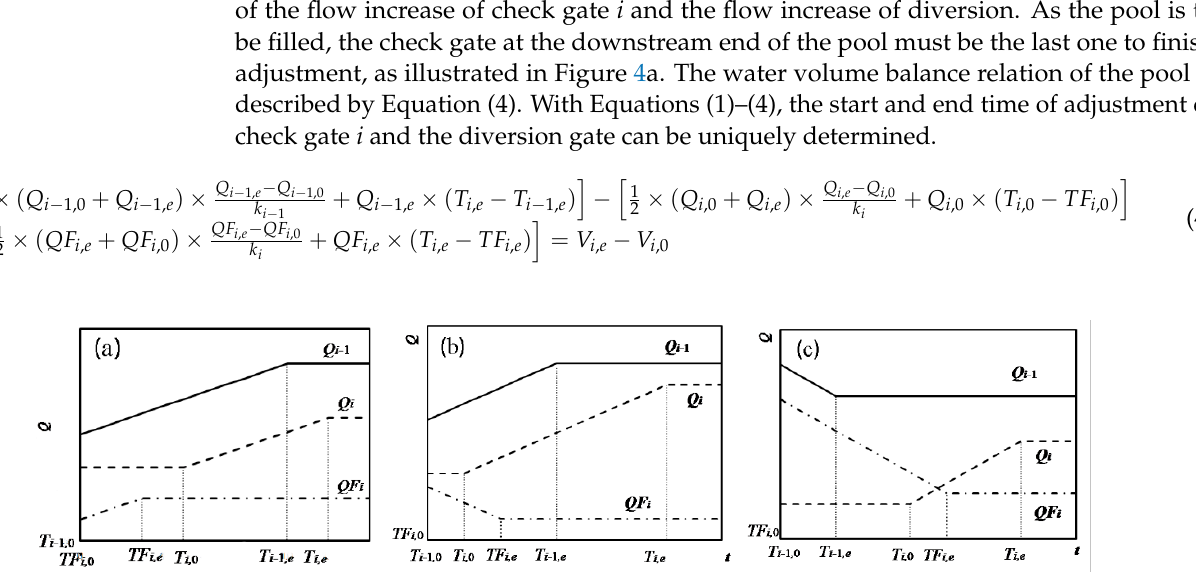
Figure 4. Scheduling of the “gate opening with water filling” case. ( a ) diversion flow increases; ( b ) diversion flow decreases, inflow increases; ( c ) diversion flow decreases, inflow decreases.